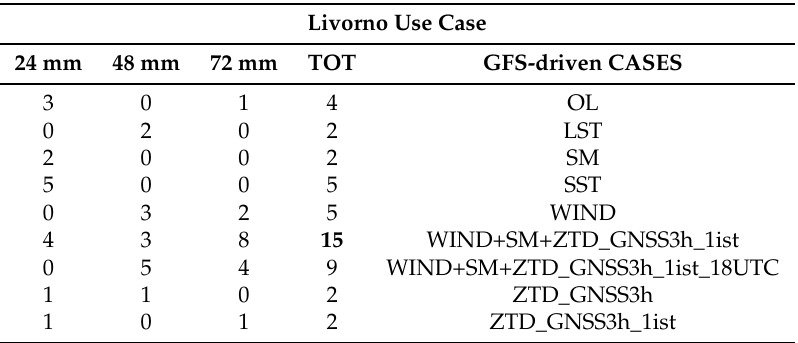
Table A5. Summary of the sensitivity performances (GFS-driven cases). The times in which each forecast has the best result for each score is counted for each threshold and summarized in a total count (summing Tables A2–A4) that is used to find the best simulation.